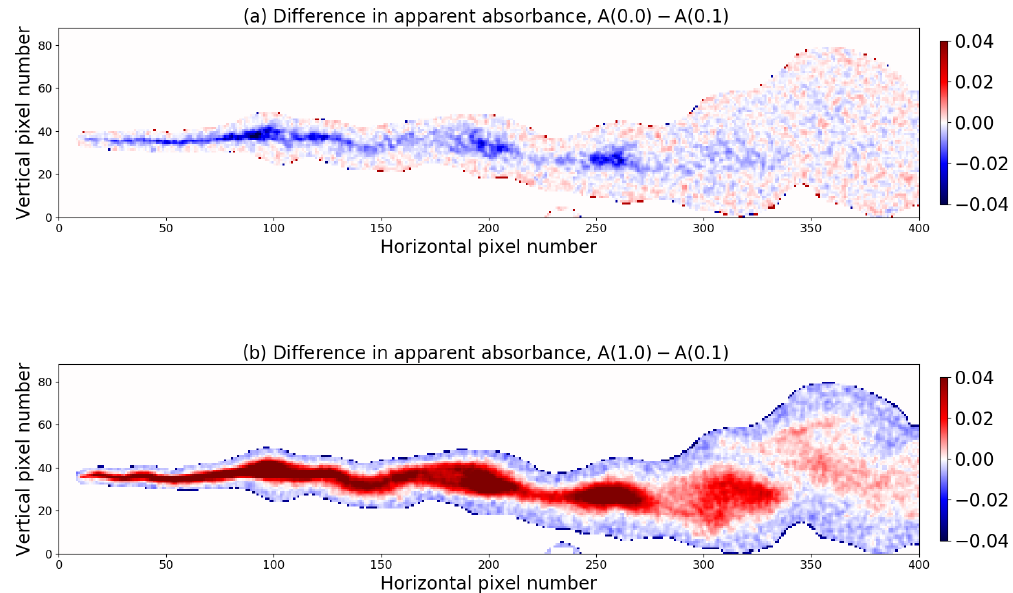
Figure 11. The difference in apparent absorbance from images recorded with a surface albedo of (a) A(0.0) and A(0.1) and (b) A(1.0) and